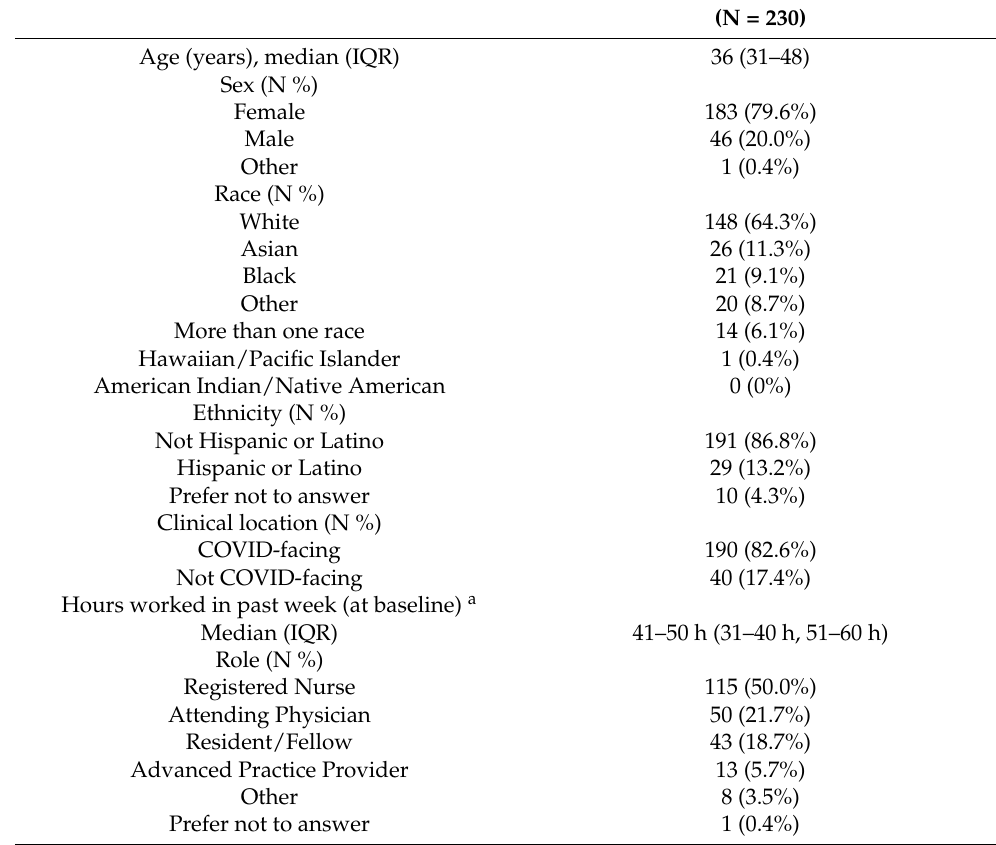
Table 1. Baseline characteristics of participants who agreed to participate in the longitudinal follow- up assessments (N =